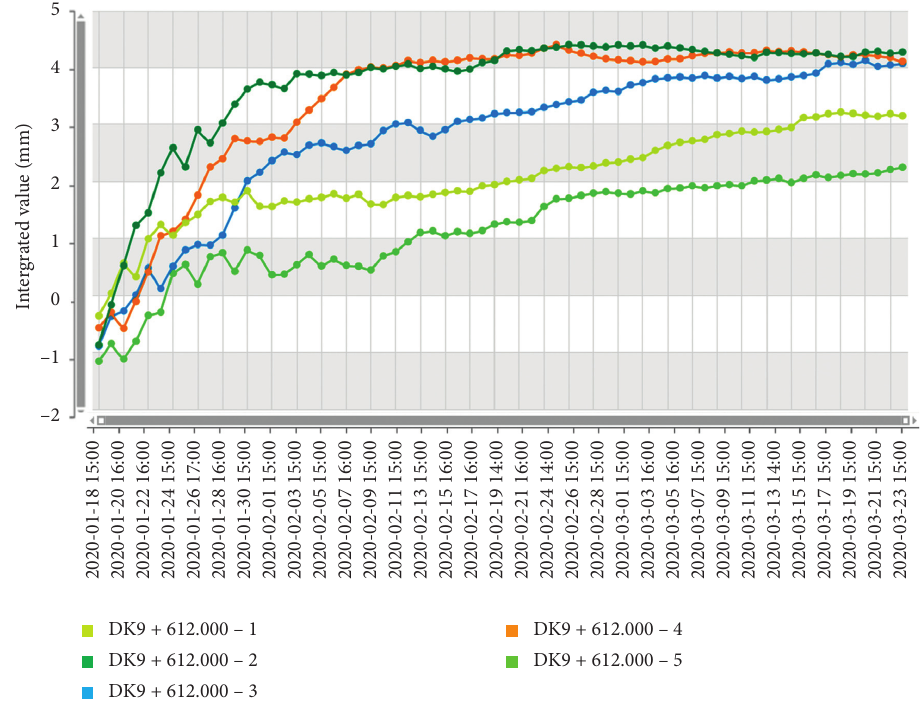
Figure 18: Rebound deformation at the bottom of foundation pit.